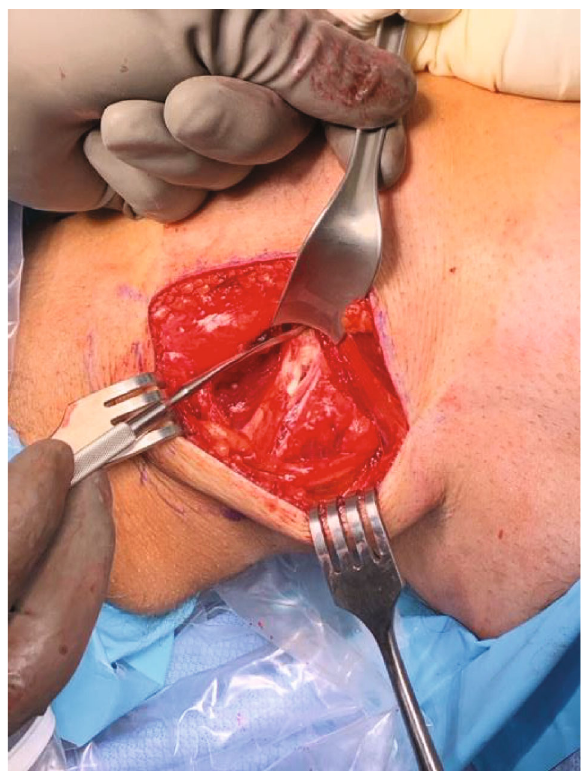
Figure 3: Lateral gastrocnemius tendon exposure.